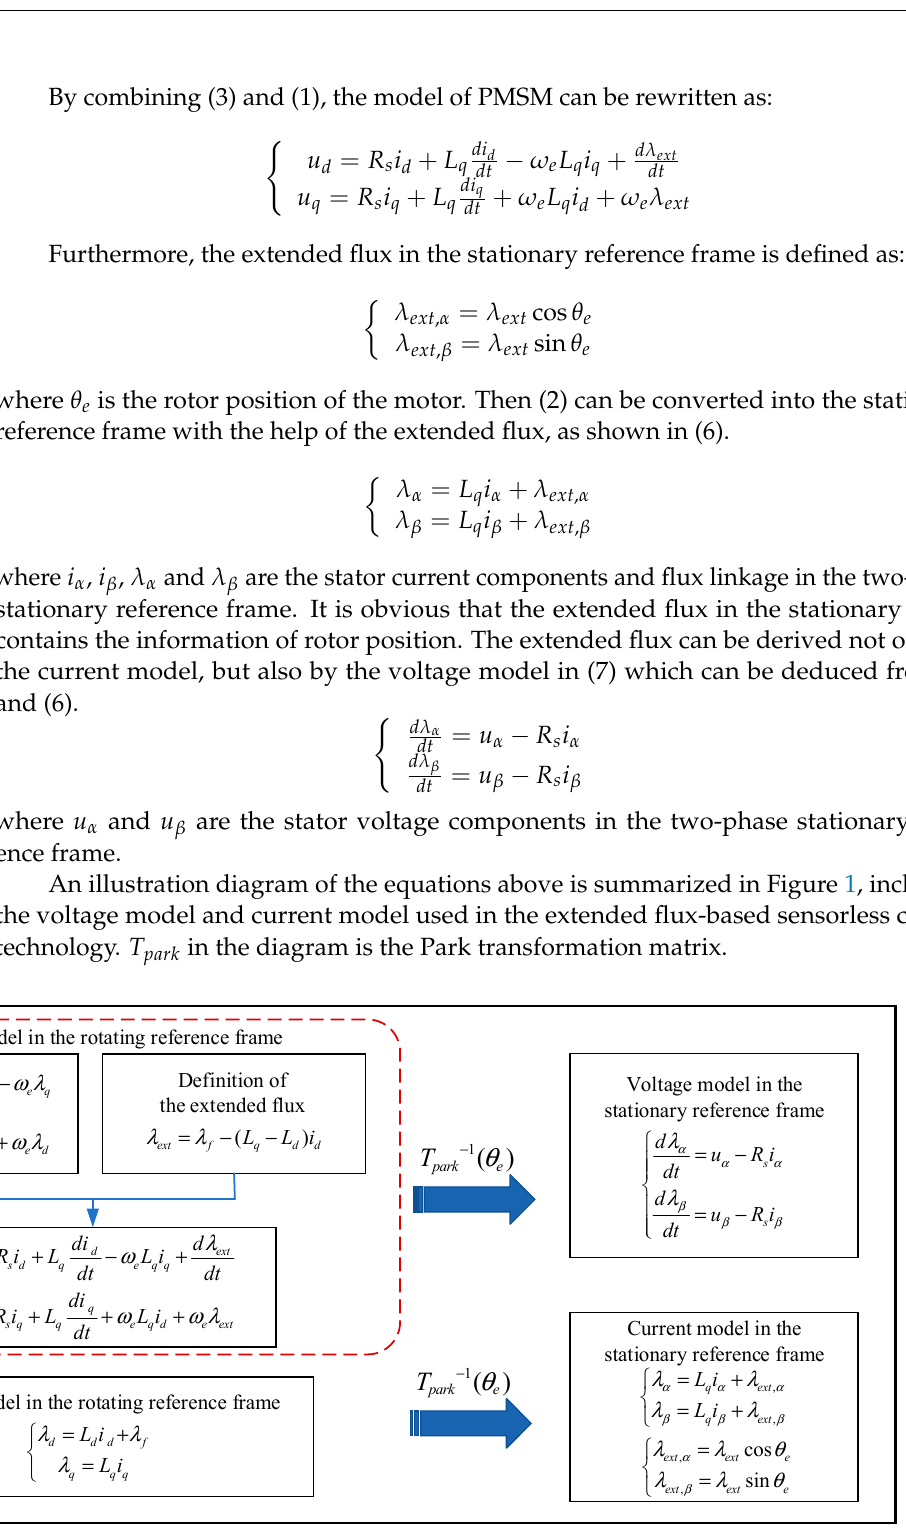
Figure 1. Illustration diagram of the model equations used in the extended flux-based sensorless control technology.